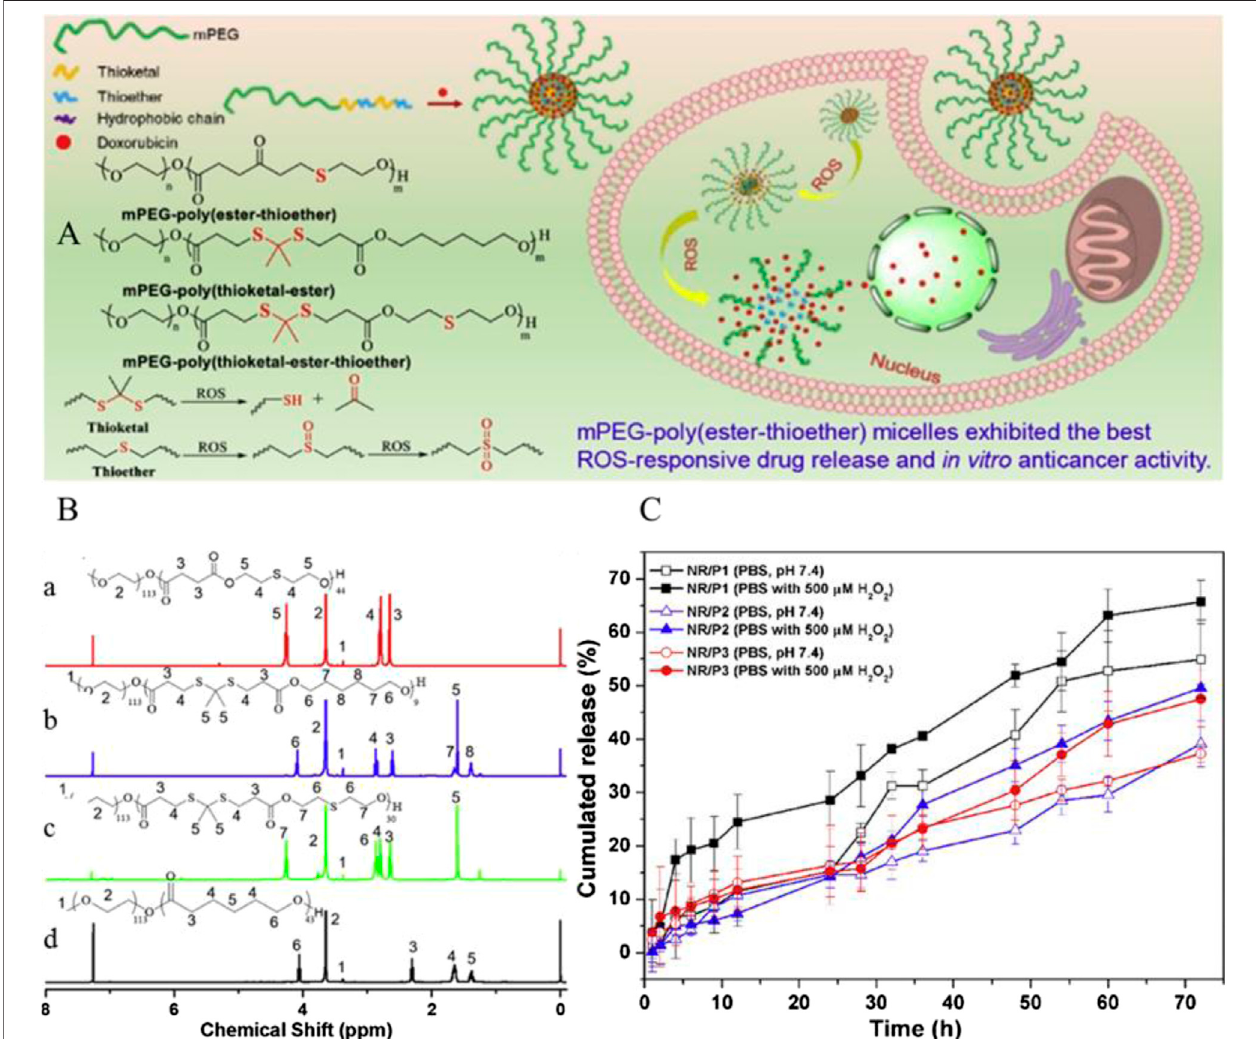
FIGURE 8 | (A) Schematic diagram of ROS-responsive nanoparticles and chemical structure of mPEG – poly(ester-thioether), mPEG – poly(thioketal-ester), and mPEG – poly(thioketal-ester-thioether). (B) Structures of mPEG – poly(ester-thioether) (a) , mPEG – poly(thioketal-ester) (b) , mPEG – poly(thioketal-ester-thioether) (c) , and mPEG-b-PCL (d) werecon fi rmedby1HNMRspectrausingCDCl 3 asthesolvent. (C) GraphoftheDOX-loadedP1,P2,andP3micelledrugreleasein500 μ MH 2 O 2 (Xu et al., 2019). Copyright 2019, Elsevier.